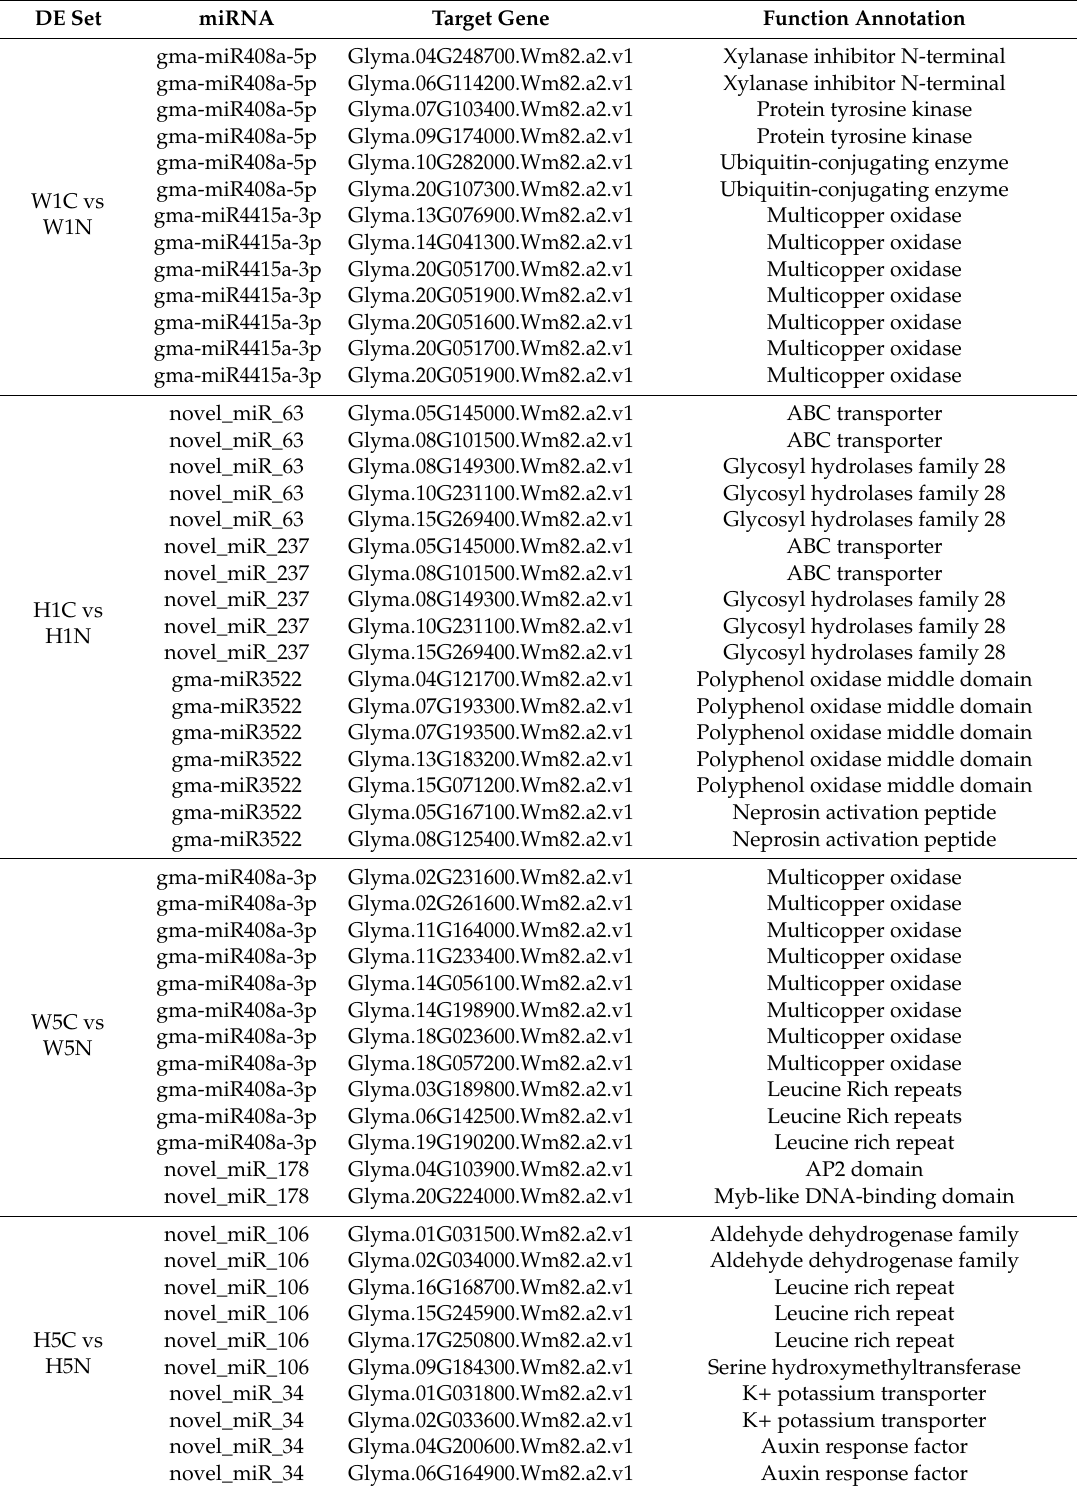
Table 4. Function annotation of the potential target genes of di ff erentially expressed